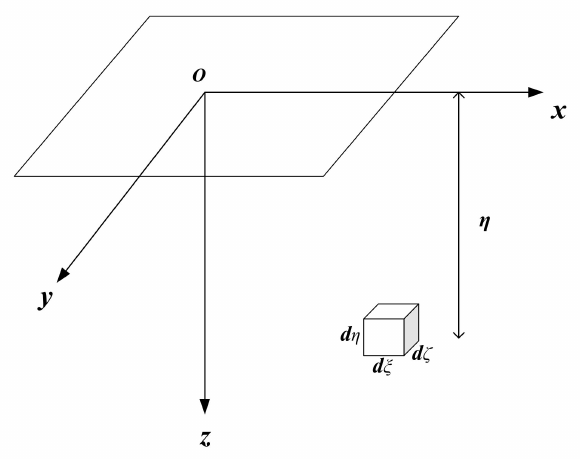
Figure 2. Schematic of stochastic medium theory.